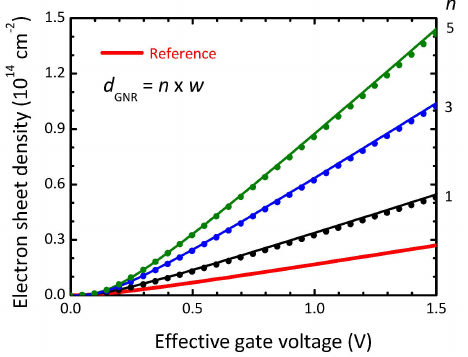
Figure 9. Electron sheet density in multiple-channel GNR MOS structures as a function of effective gate voltage. Green, blue, and black lines: Obtained when simulating the multiple-channel GNR MOS structure from Figure 4c, thereby using the original values for the dielectric constants for the gate dielectric ( ε r = 25) and the GNRs ( ε r = 1.8). Symbols: Obtained by simulating the single-channel GNR MOS structure from Figure 4a applying the correction factor method. Thick red line: Obtained by simulating the single-channel GNR MOS structure from Figure 4a, thereby using the original values for the dielectric constants for the gate dielectric ( ε r = 25) and the GNRs ( ε r = 1.8), designated as